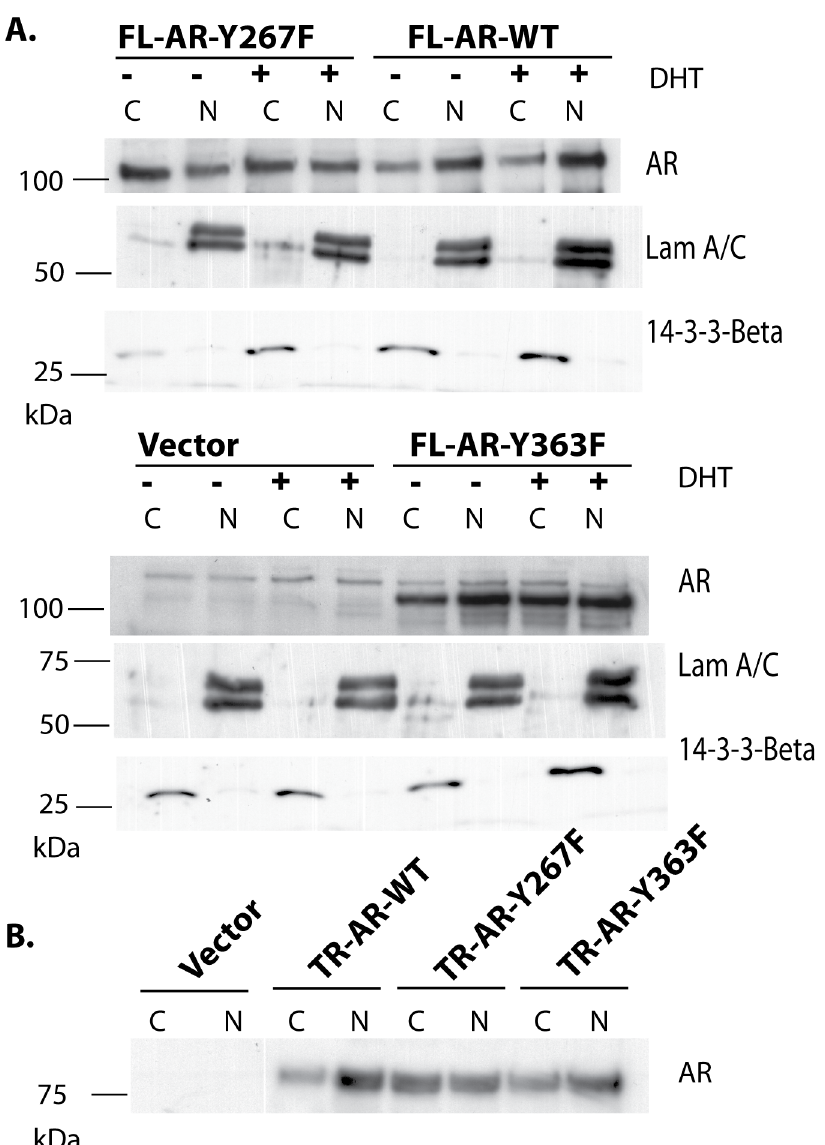
Fig 7. The AR Y267F mutant is defective in nuclear localization in LNCaP cells. (A) LNCaP cells stably overexpressing vector or AR constructs were grown in phenol red free media and serum starved for overnight and treated with or without 10 nM DHT for 2 hrs. Cell fractionation was performed. The cytoplasmic and nuclear lysates from LNCaP cells expressing full length AR constructs were subjected to immunoprecipitation with FLAG antibody, followed by immunoblotting with AR antibody, as indicated. Laminin A/C and 14-3-3 β were used as markers of nuclear and cytoplasmic fractions, respectively. (B) The cytoplasmic and nuclear lysates from LNCaP cells stably expressing truncated AR constructs under androgen-deprived conditions were subjected to immunoprecipitation with FLAG antibody, followed by immunoblotting with AR antibody, as indicated. Laminin A/C and 14-3-3 β were used as markers of nuclear and cytoplasmic fractions,